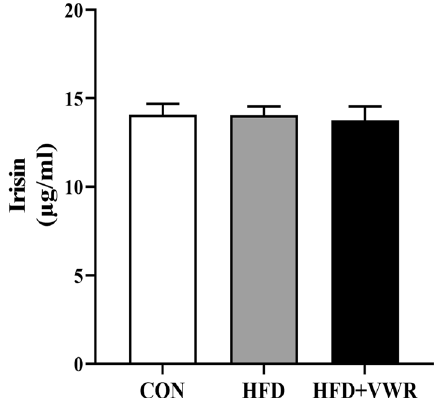
Fig. 4 Effects of chronic HFD and VWR exercise on irisin in serum. Values are shown as mean